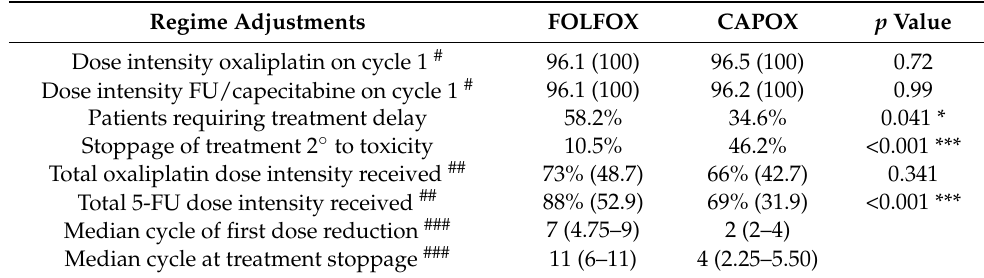
Table 7. Treatment Regime Adjustments Secondary to Chemotherapy-Induced